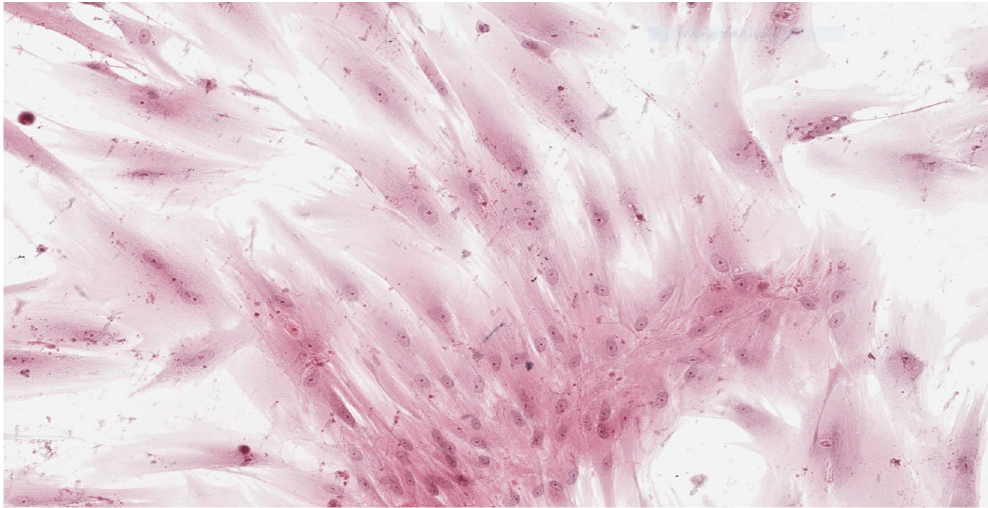
Figure 5. Image of cells cultured on medium with PROTEFIX; 100 × magnification.